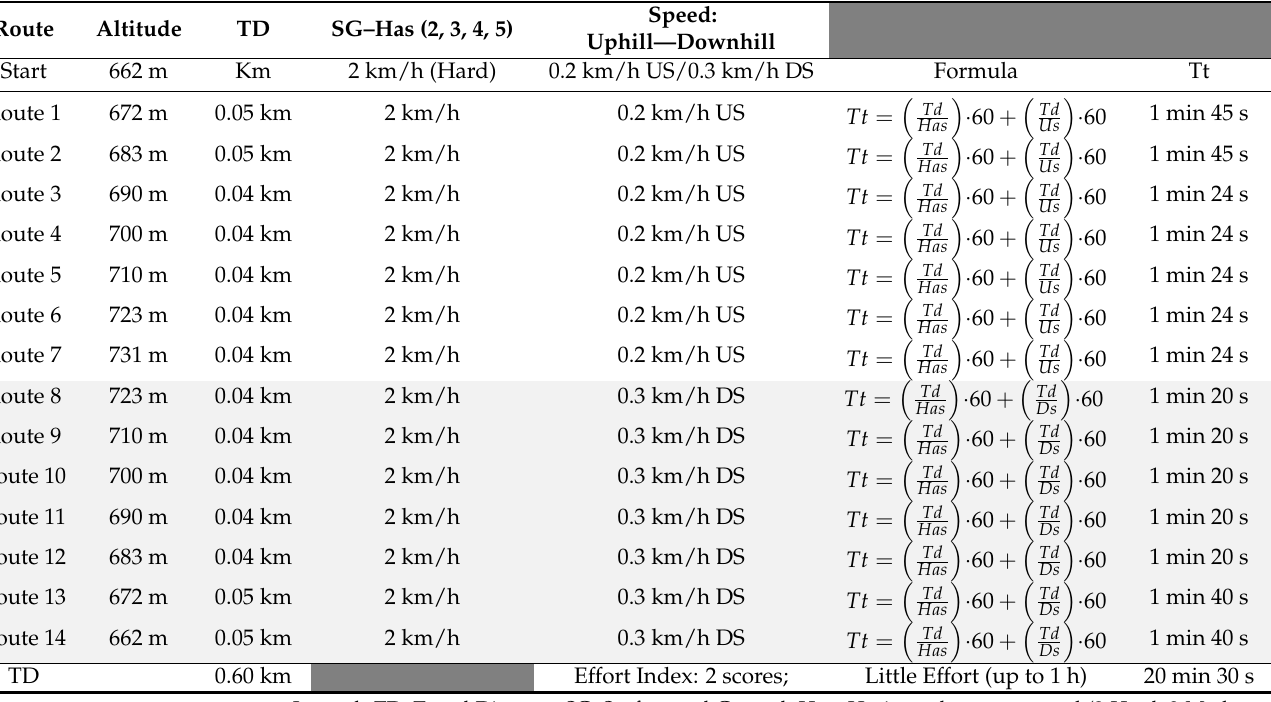
Legend: TD: Travel Distance; SG: Surface and Ground; Has: Horizontal average speed (2 Hard, 3 Moderate, 4 Easy, 5 Very Easy); Us: Uphill speed; Ds: Downhill Speed; Tt: Travel Time. Effort Index: Little Effort (up to 1 h); Moderate (1 to 3 h); Significant (3 to 6 h); Intense (6 to 10 h); Extraordinary (over 10 h). Source: ABNT-NBR 15505.2 [85] adapted for